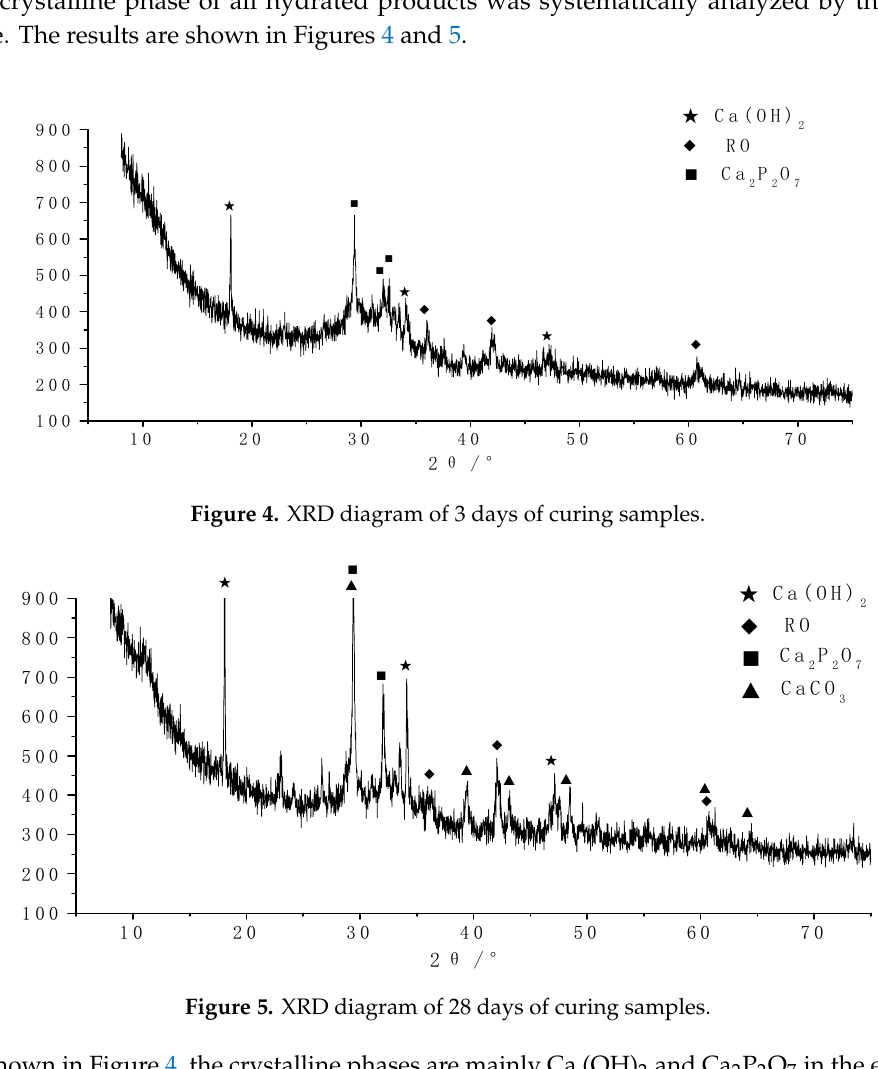
Figure 5. XRD diagram of 28 days of curing samples.